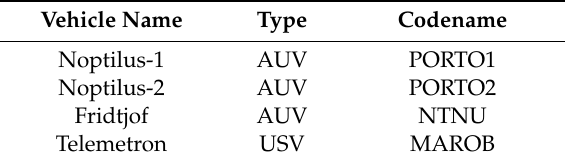
Table 2. Details for the vehicles used during the tests involving the MTRR.